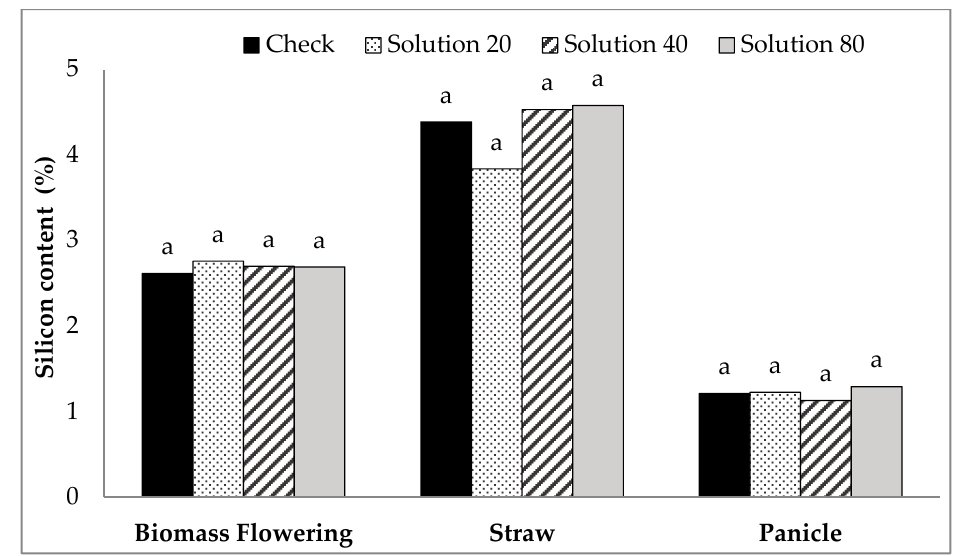
Figure 6. Effect of foliarly applied silicon at different rates on silicon content of biomass at flowering and straw and panicle at harvest. Bars labeled with the same letter within sampling type are not significantly different at P < 0.05 according to Tukey’s test.